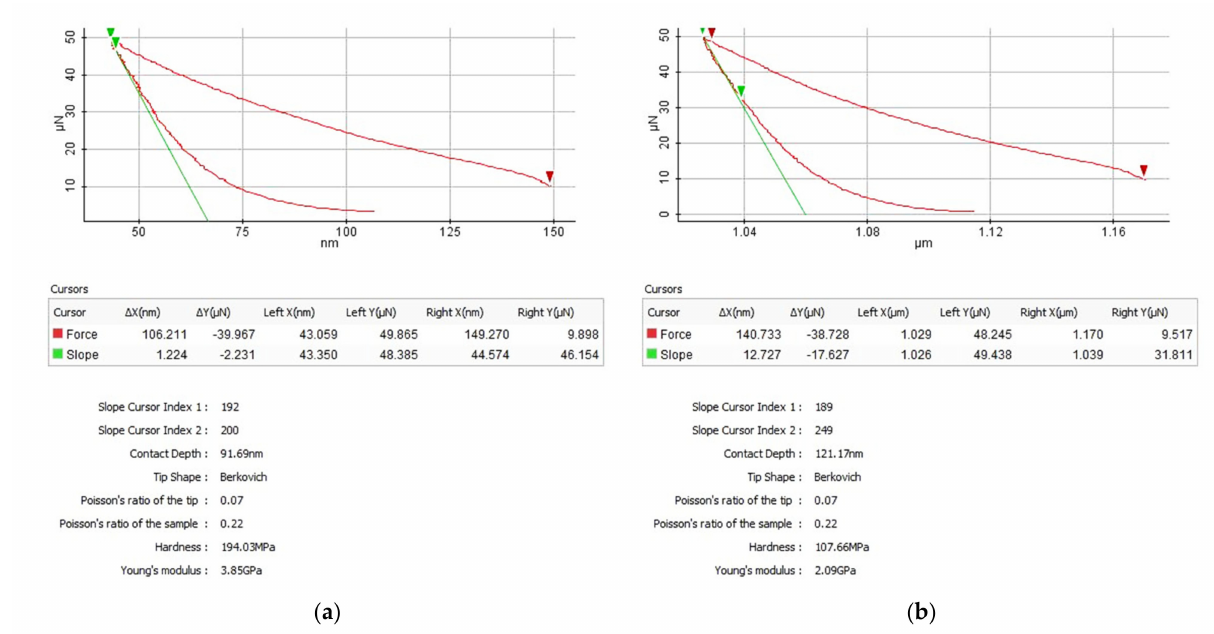
Figure 2. Nanoindentation of SU-8 hard baked at 125 ◦ C, tested at 20 ◦ C ( a ) and 100 ◦ C ( b ).